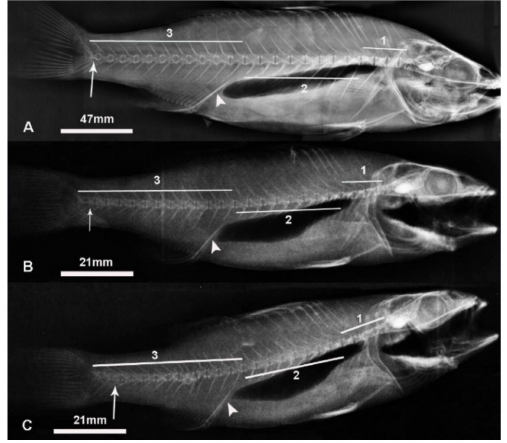
Figure 1. X-ray of ( A ) adult European seabass with 24 vertebrae, ( B ) juvenile European seabass with 25 vertebrae and ( C ) juvenile European seabass with 26 vertebrae. Note: 1 is cervical region, 2 is abdominal region and 3 is caudal region. The arrowhead shows the interhaemal bone and the arrow shows the 24th vertebra. Individuals with di ff erent vertebrae numbers (24, 25 and 26 vertebrae) but within the same age group had similar mean total lengths ( p >